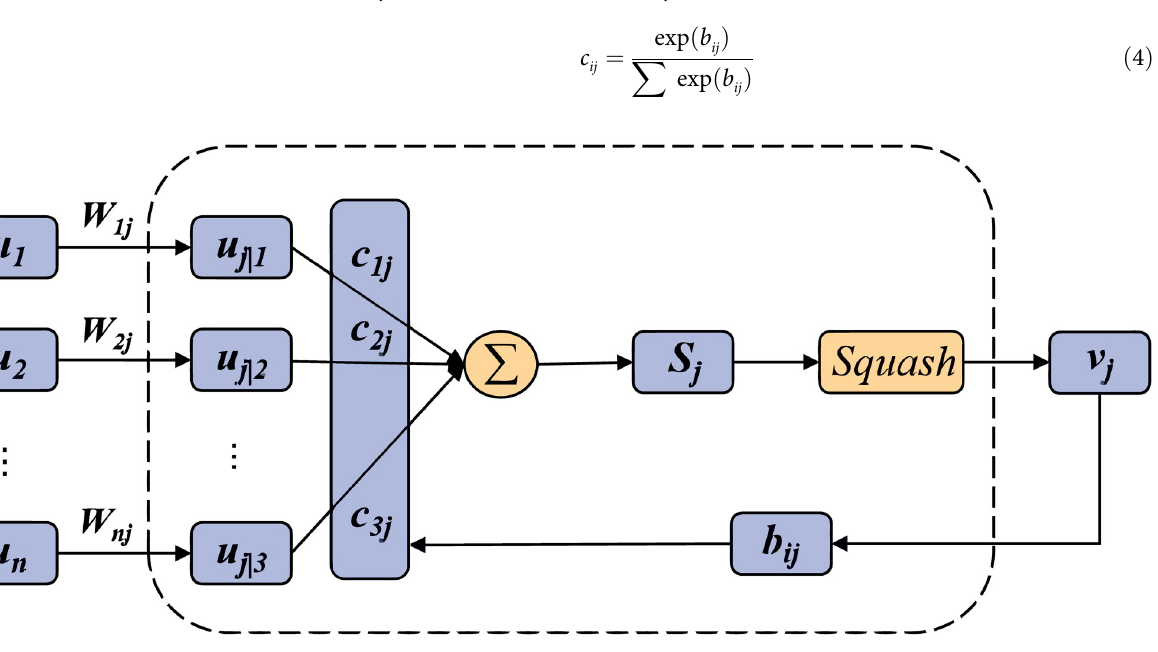
Fig 6. The calculation process of dynamic